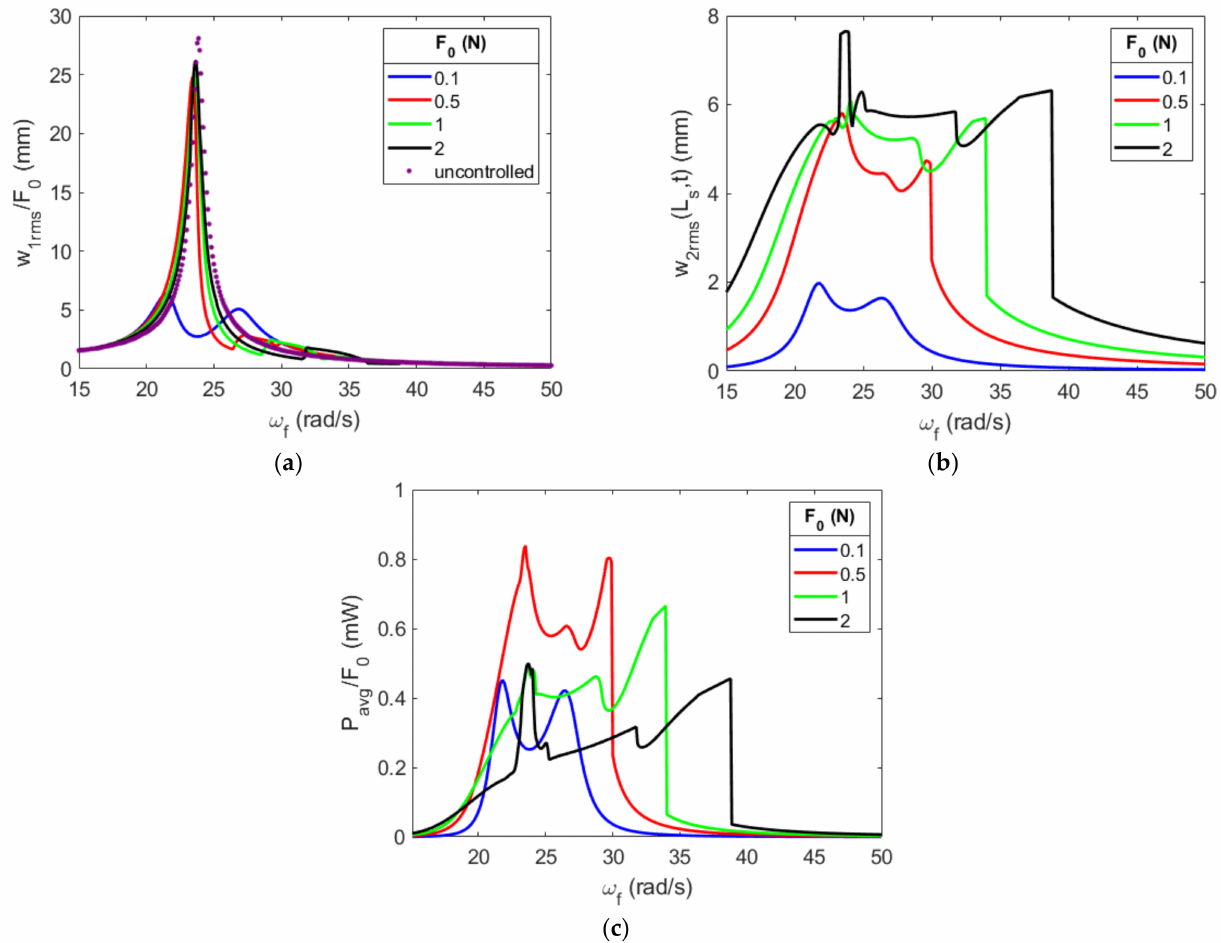
Figure 30. Forcing amplitude effects with a gap of 10 mm on the ( a ) primary structure’s normalized displacement, ( b ) the absorber’s displacement and ( c ) the normalized power